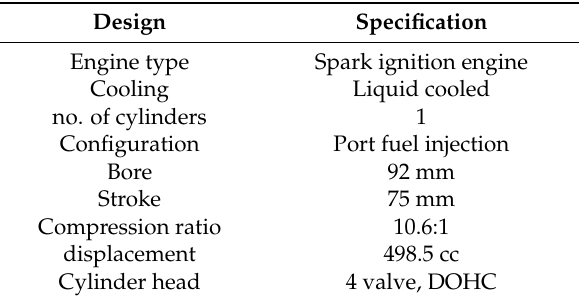
Table 1. Test engine